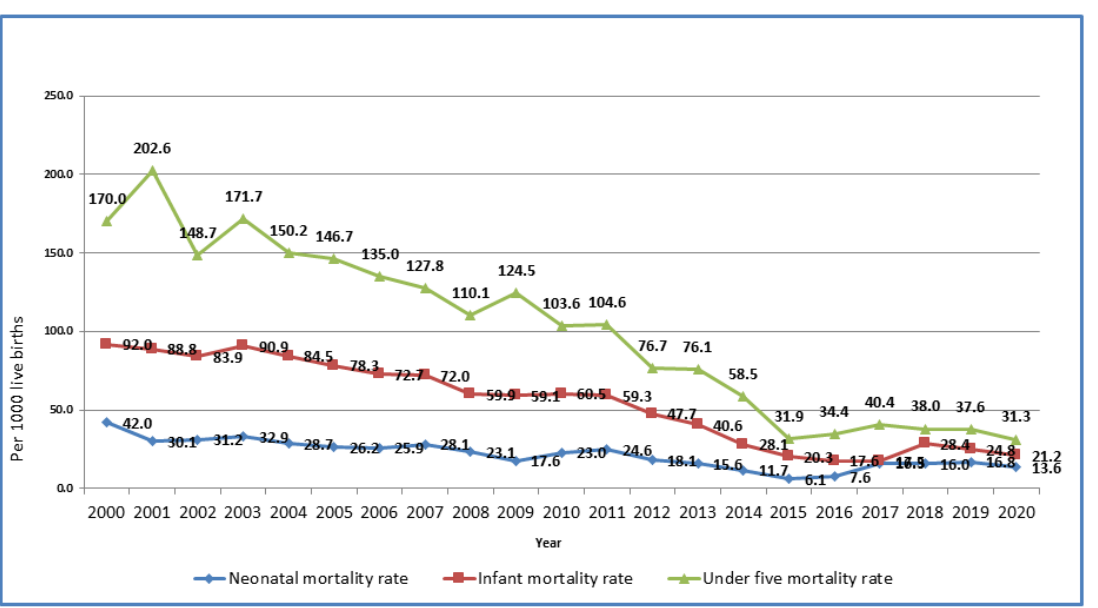
Figure 3. Trends of neonatal, infant and child mortality in Manhiça district from 2000 to 2020. Source: Manhiça HDSS databases,